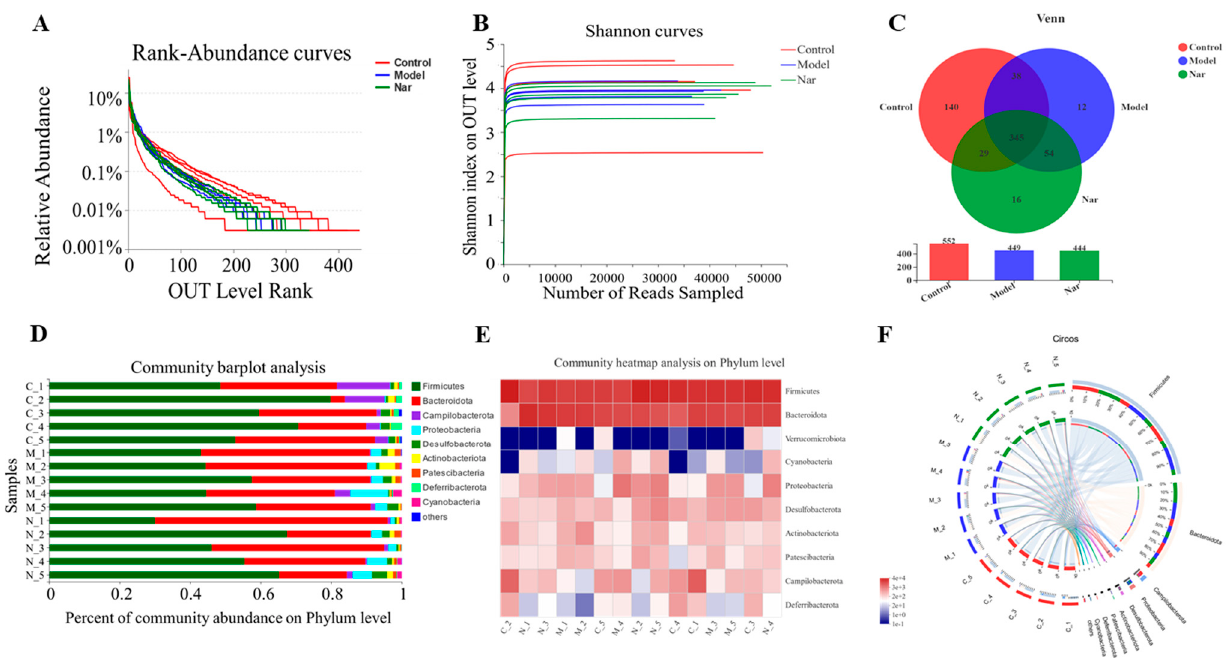
Figure 6. Naringin regulated on the disturbed gut microbiota in DSS-induced colitis mice. ( A ) Rank-Abundance curves of the OUT level. ( B ) Shannon dilution curves. ( C ) Venn diagram of species in the three groups. ( D ) Histogram of intestinal microbial community structure at the phylum level. ( E ) Community heatmap analysis in the phylum levels. ( F ) Circos of samples and species in the phylum levels.